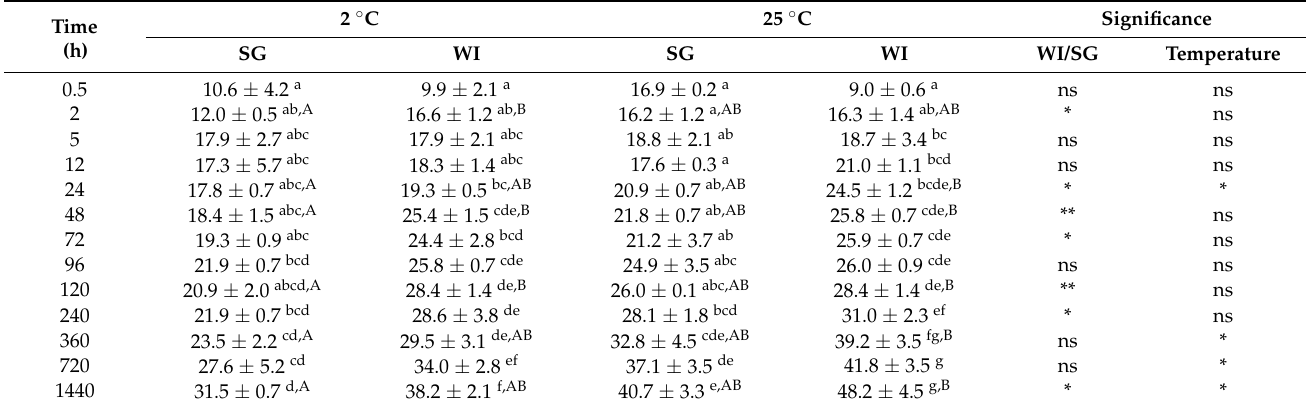
Table 3. Effect of time on sodium benzoate delivery (%) in orange juice at 2 ◦ C and 25 ◦ C.